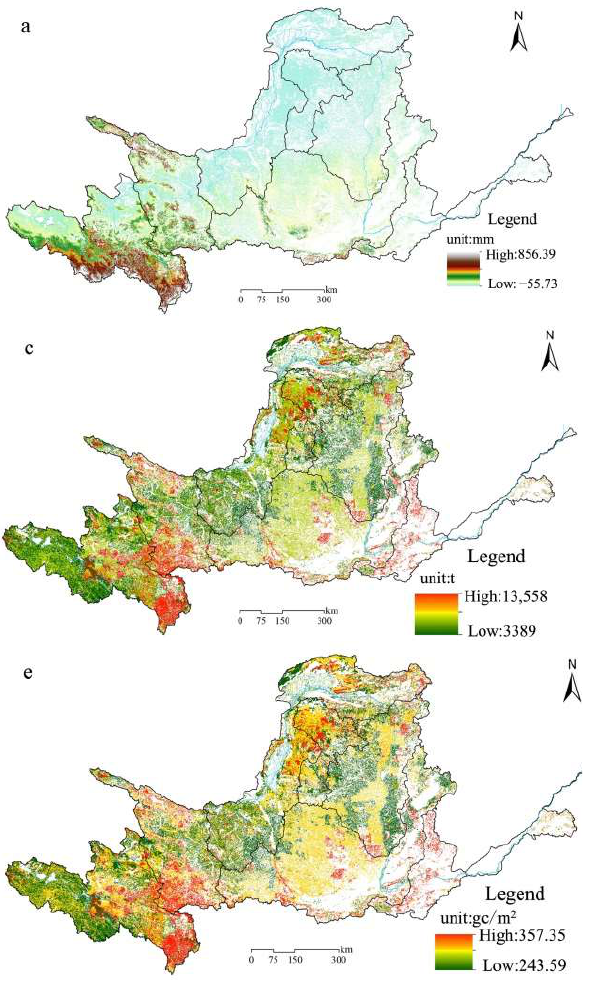
Figure 2. Spatial distribution of five ecosystem services in the grassland of the Yellow River basin (( a ): water yield, ( b ): soil conservation, ( c ): carbon stock, ( d ): habitat quality, ( e ): NPP).